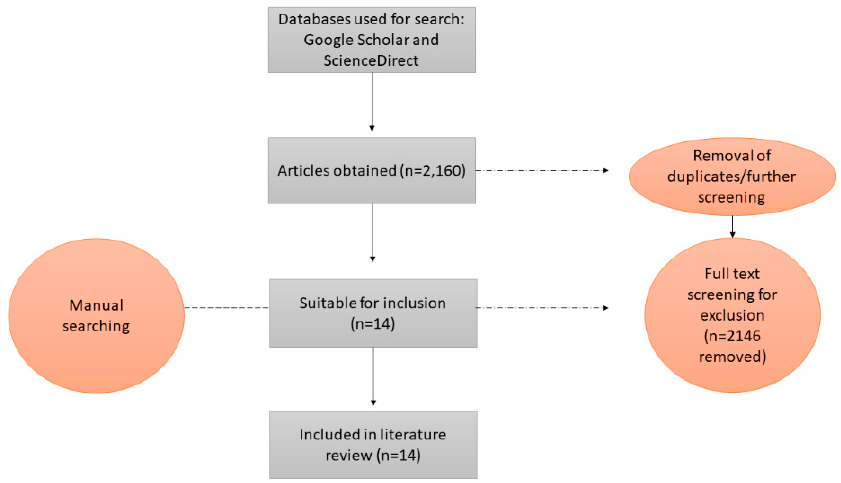
Figure 4. Process of literature selection for systematic review.